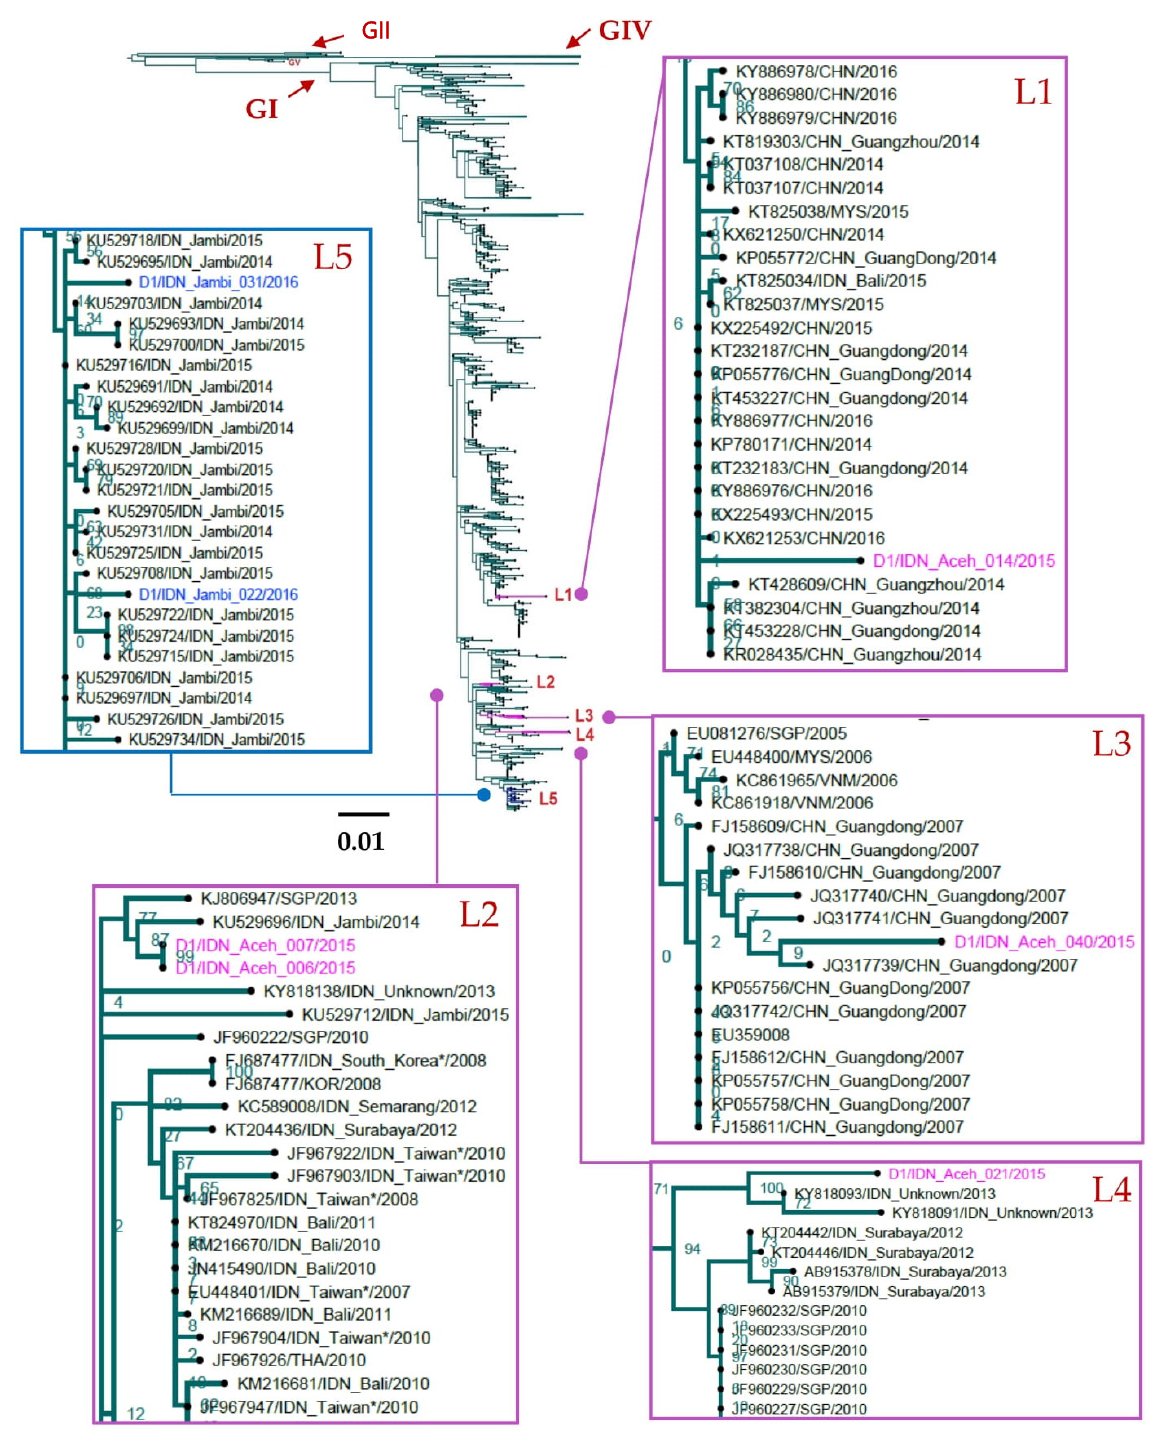
Figure 2. Phylogenetic tree of DENV-1 isolated from Aceh and Jambi showing Lineages 1–5. The phylogenetic tree was generated using the maximum likelihood method using RAxML with a GTR+ Γ model with 4268 sequences from NCBI. Some phylogenetic clusters have been collapsed to reveal the positions of isolated viruses in more detail. Pink indicates viruses isolated from Aceh and blue indicates viruses isolated from Jambi in this study. G: genotype, L: lineage. CHN: China, IDN: Indonesia, SGP: Singapore, THA: Thailand. Asterix (*) indicates virus isolated from travelers returning from Indonesia.